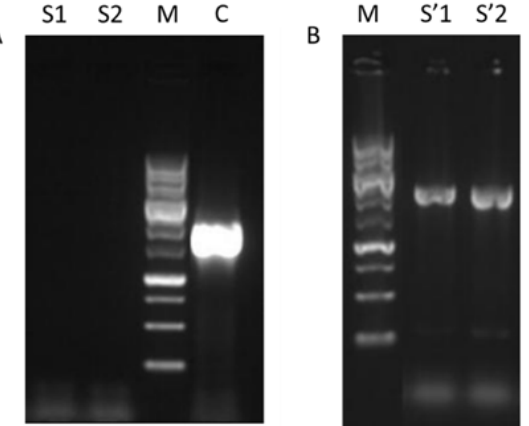
Figure 1. Electrophoresis of PCR products for W_M4_533 validation. ( A ) Validation of MSN4 deletion (S1, S2: W_M4_URA3 candidate colonies 1 and 2 respectively, M: Molecular weight marker (MWD-1, Nippon Genetics), C: W303-1a). ( B ) Validation of MSN4_S533A gene insertion for W_M4_533 genera- tion (M: Molecular weight marker, S’1 and S’2: W_M4_533 candidate colonies 1 and 2